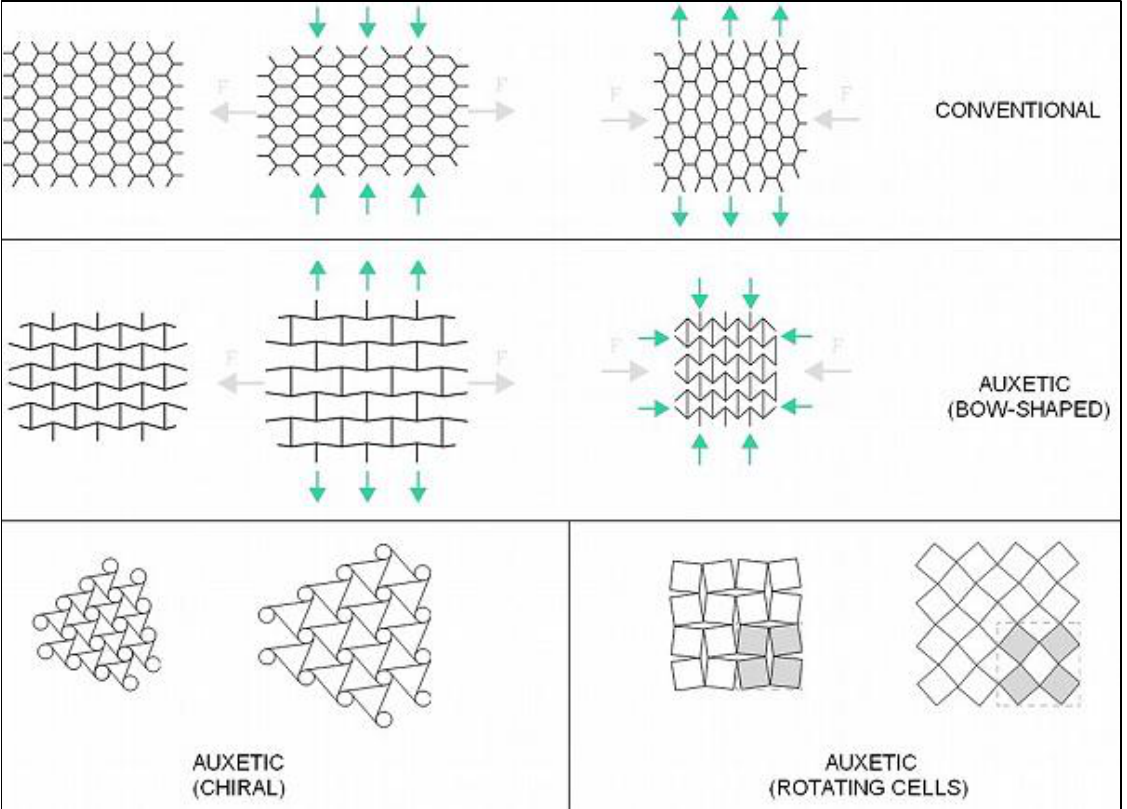
Figure 9. Deformation patterns of Newtonian and auxetic cellular structures